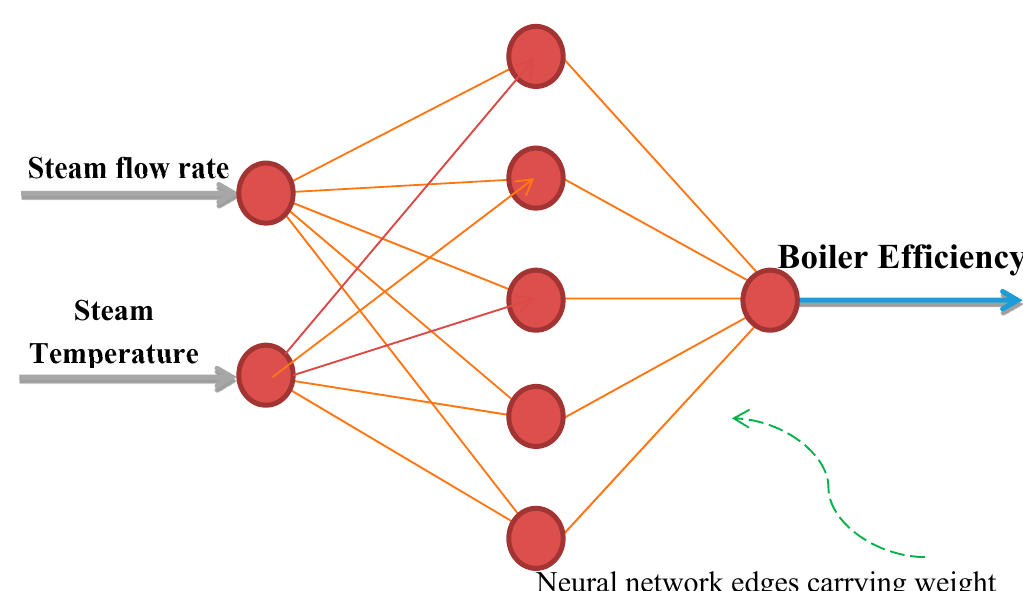
Figure 4. Sample schematic structure of a 2-5-1 neural network model: Two neurons in the input layer, five neurons in the hidden layer, and a neuron in the output layer.